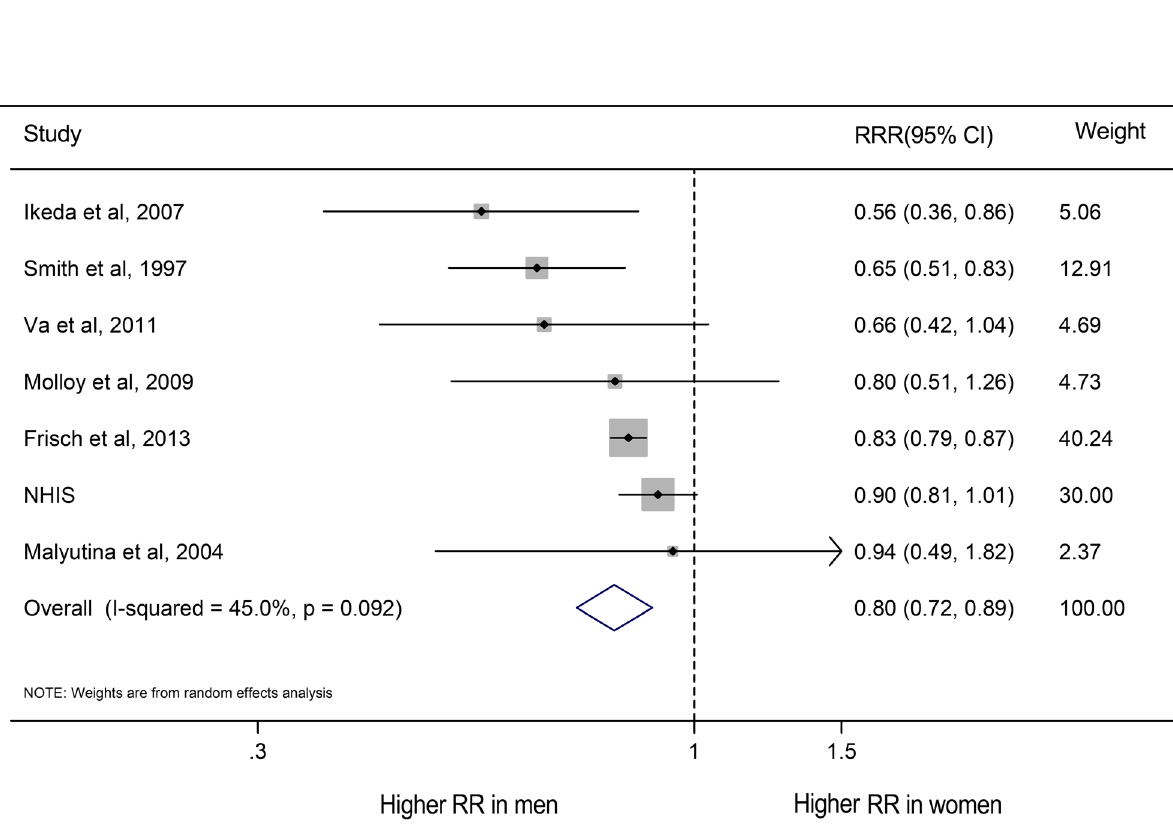
Fig. 5 Women-to-men ratios of relative risks (RRRs) for CVD mortality comparing married to non-married people. The boxes and lines indicate the RRRs and their 95% confidence intervals (CIs) on a log scale for each study. The pooled odds ratio is represented by a diamond. The size of the gray squares indicate the relative weight of each